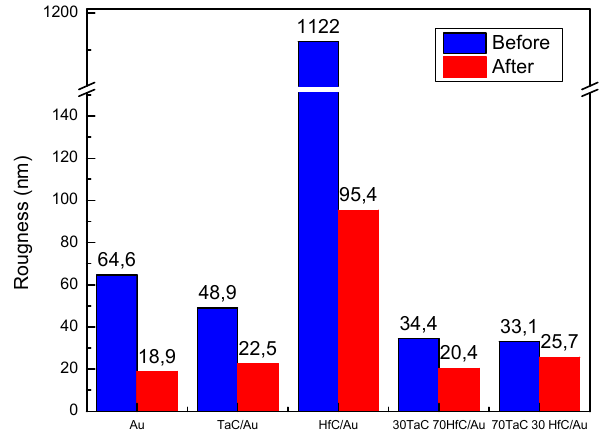
Figure 8. Quantitative variation of the roughness measurements before and after micro-abrasion test using AFM technique and analyzed by SPIP Image Metrology software.